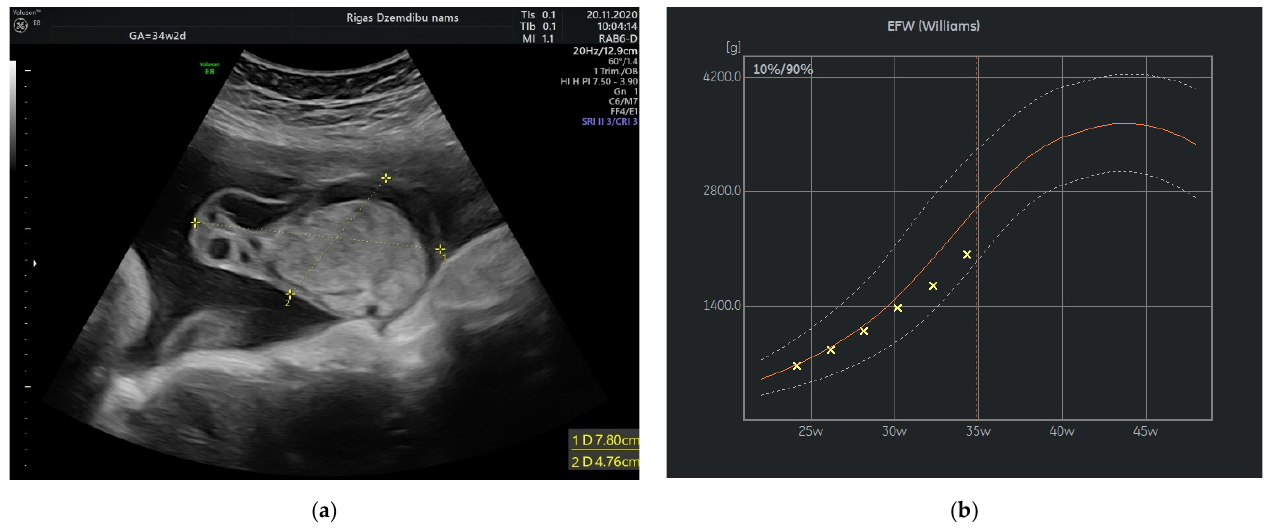
Figure 3. ( a ) Tumor appearance at 34 + 2 weeks; ( b ) Growth chart, estimated fetal weight by weeks.